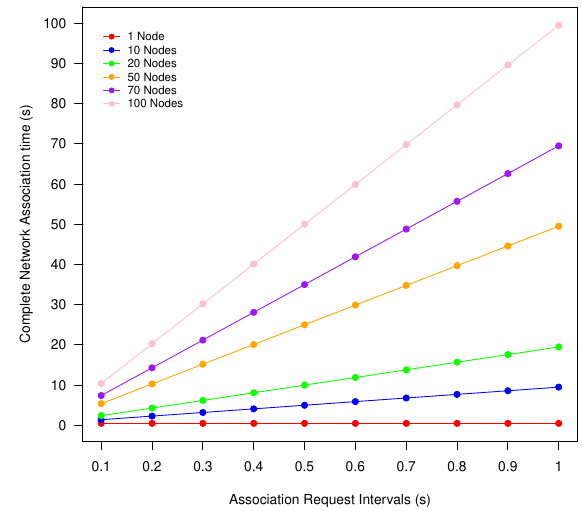
Figure 9. Full network association time (interval 0.1–1 s).